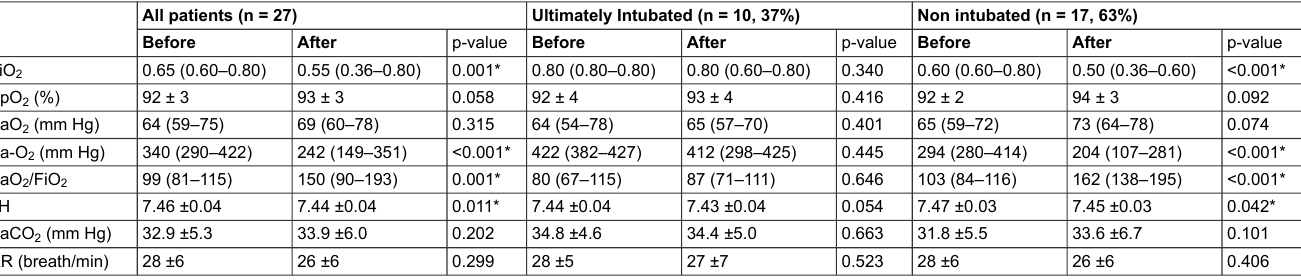
Table 2: Physiological parameters before and after the first pronation session in the global patient population with blood gas analyses available for the first aPP (n = 27), in the subgroup of patients who did not later require intubation and in the subgroup of patients who were intubated. All patients (n =